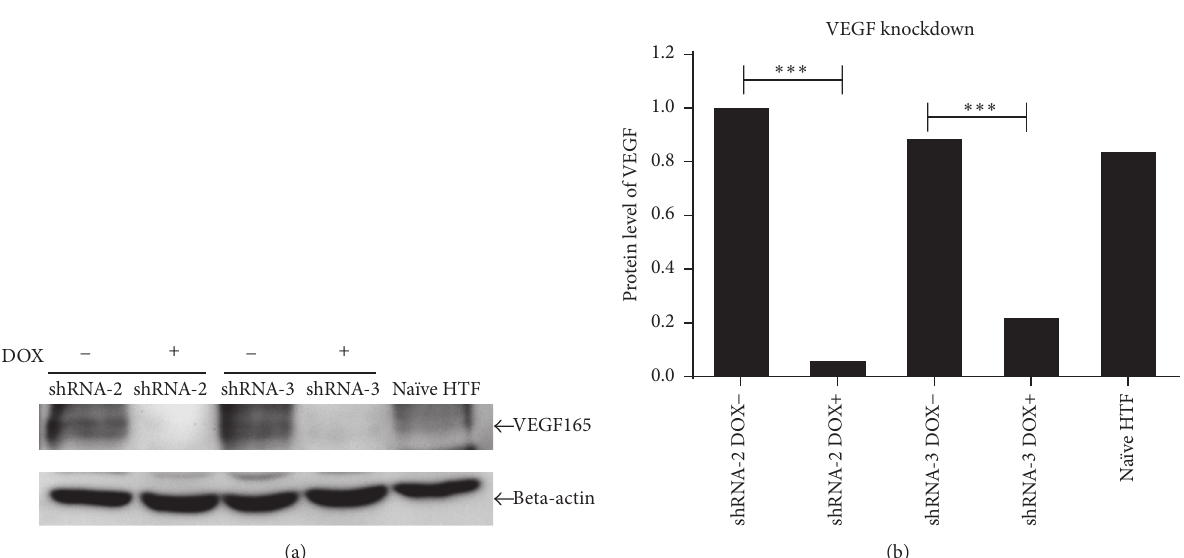
Figure 2: Western blot analysis of the effects of RNA interference on VEGF expression in HTF cells. (a) Relative expression of VEGF in cells treated with shRNA-2 and shRNA-3; (b) protein expression levels in treated groups and na¨ıve HTF controls. ∗∗∗ 𝑝 < 0.01 .